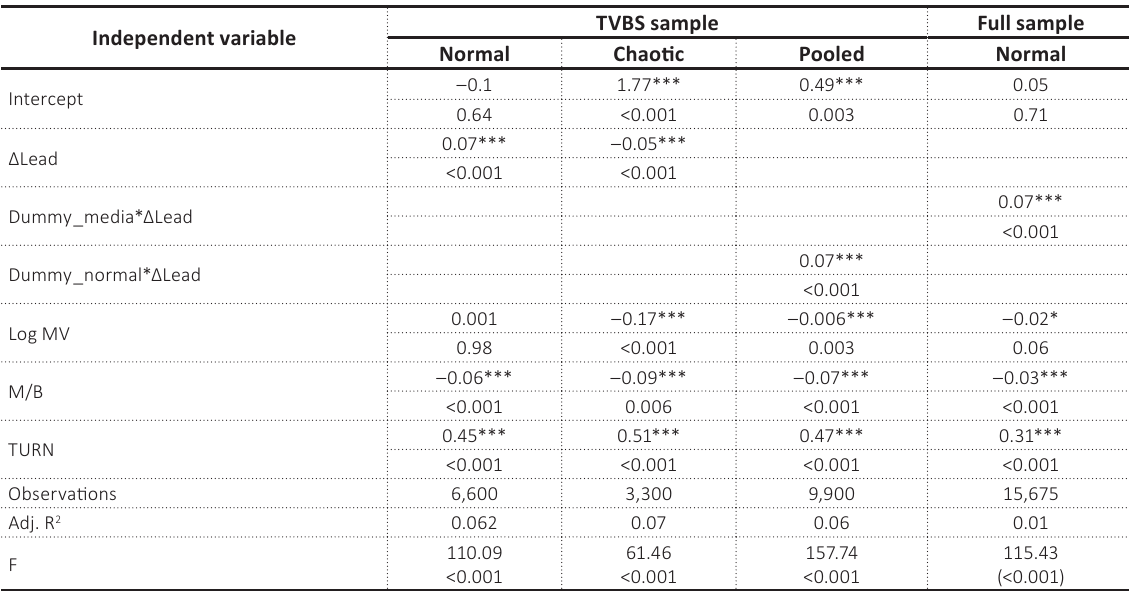
Table 6. Regressions analyses of cumulative abnormal returns for sample